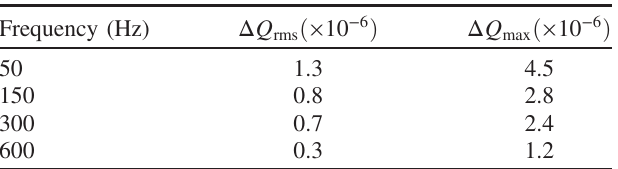
depths of the low order 50 Hz harmonics included in the simulations as computed from the power supply specifications (Table VI) and Eq. (16).